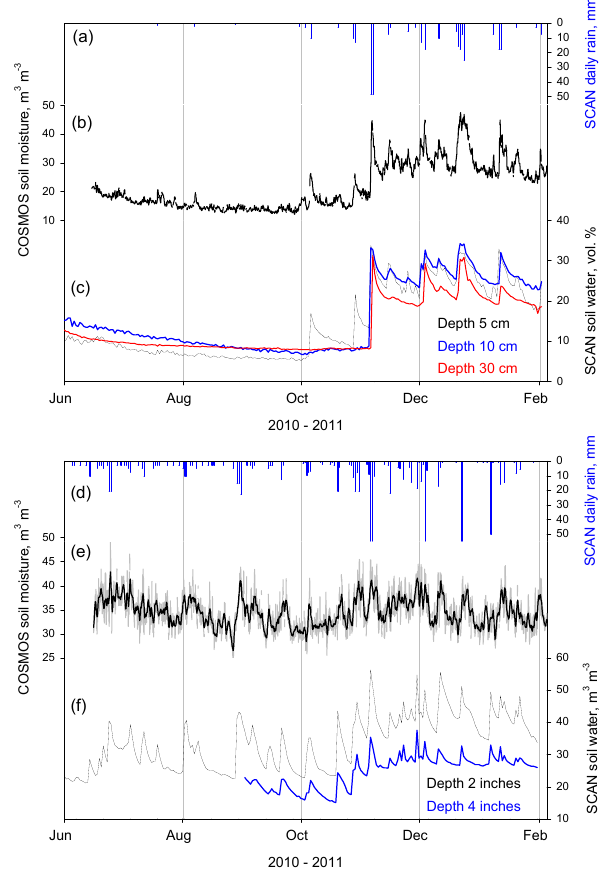
Fig. 15. (a) Precipitation from SCAN (a, d) , neutron-derived soil moisture (b, e) , and soil water content from SCAN (c, f) for two sites on the Island of Hawaii: Silver Sword (a–c) and Island Dairy (d–f) . SCAN, Soil Climate Analysis Network, is operated by the United States Department of Agriculture